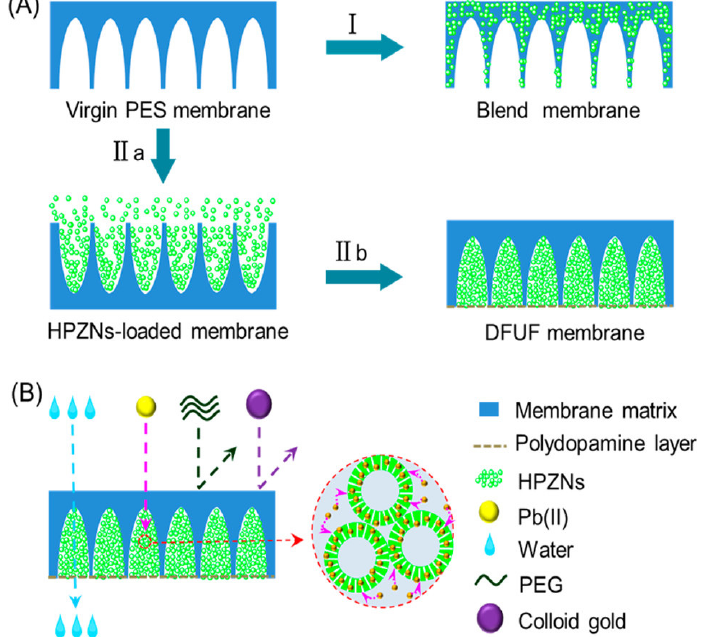
Figure 6. Schematic representation of UF membrane designs: ( A ) Virgin polymer UF membrane and a traditional blend membrane are both synthesized through a one-step casting method (I). A new 2-step method to form pre-deposited DM (Dual Function UF membrane) (II); ( B ) the purification process for polluted water by pre-deposited DM. Reproduced with permission from [134], copyright of the American Chemical